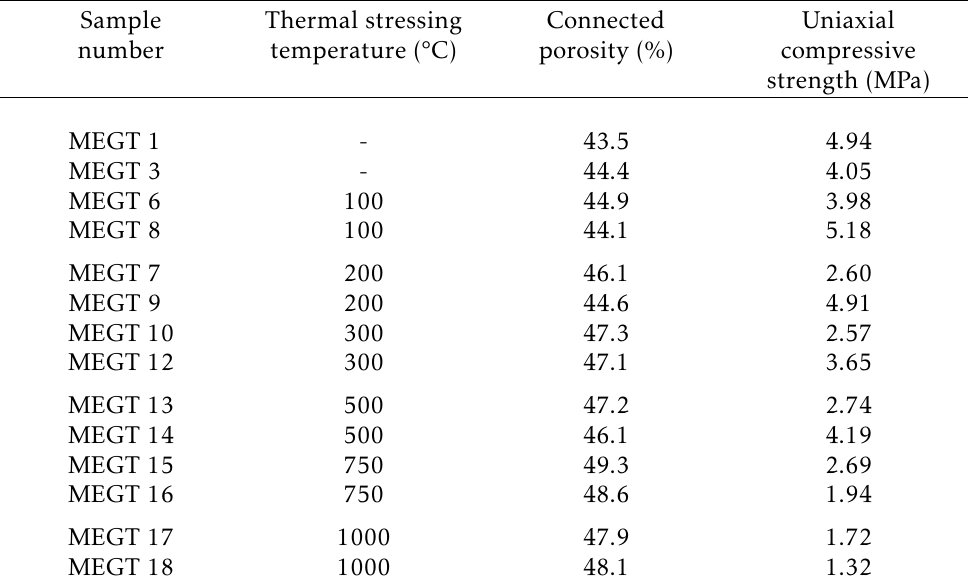
Table 2 – Summary of the experimental data collected for this study.